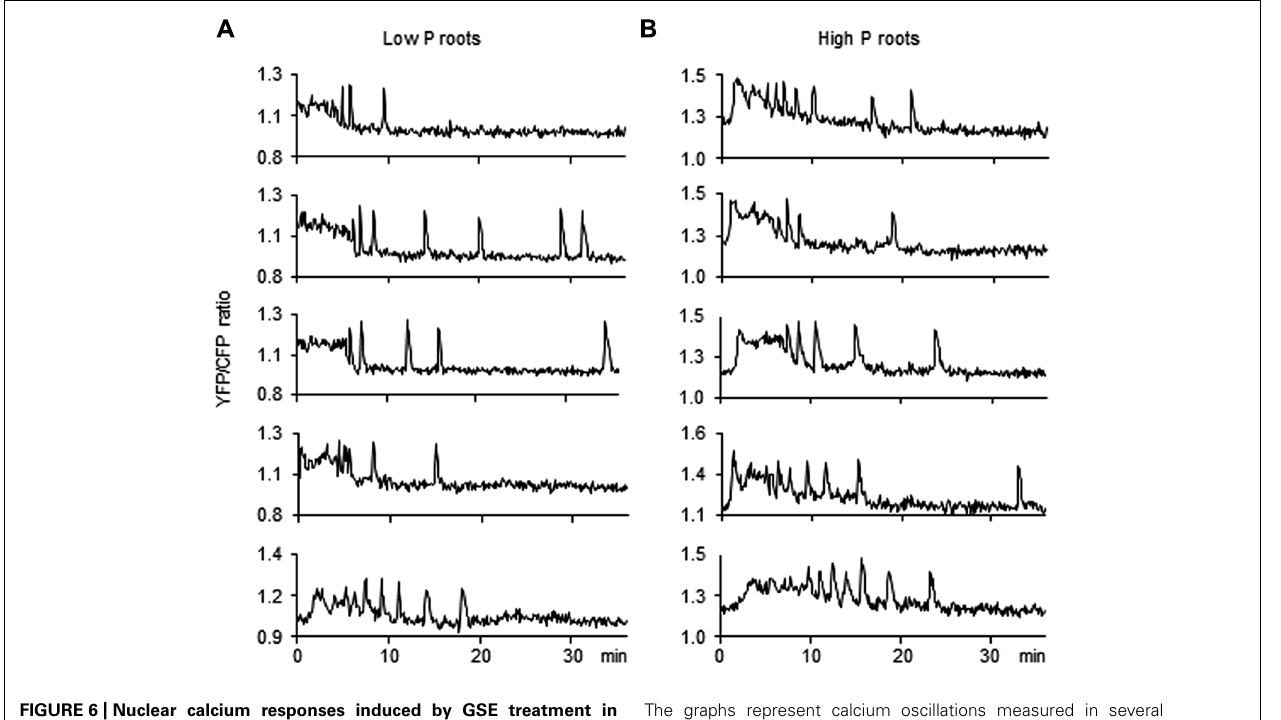
The graphs represent calcium oscillations measured in several representative nuclei for each condition. Vertical axis: arbitrary unit for YFP fluorescence/CFP fluorescence ratio, horizontal axis: time (minutes).